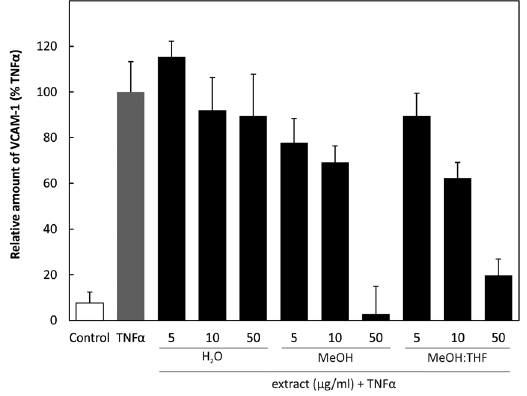
Figure 4. Flow cytometry VCAM-1: HUVEC were pre-stimulated with 5, 10 and 50 µ g/ml of extracts for 30 min as indicated and then by TNF α for 24 hours. The level of VCAM-1 was determined using flow